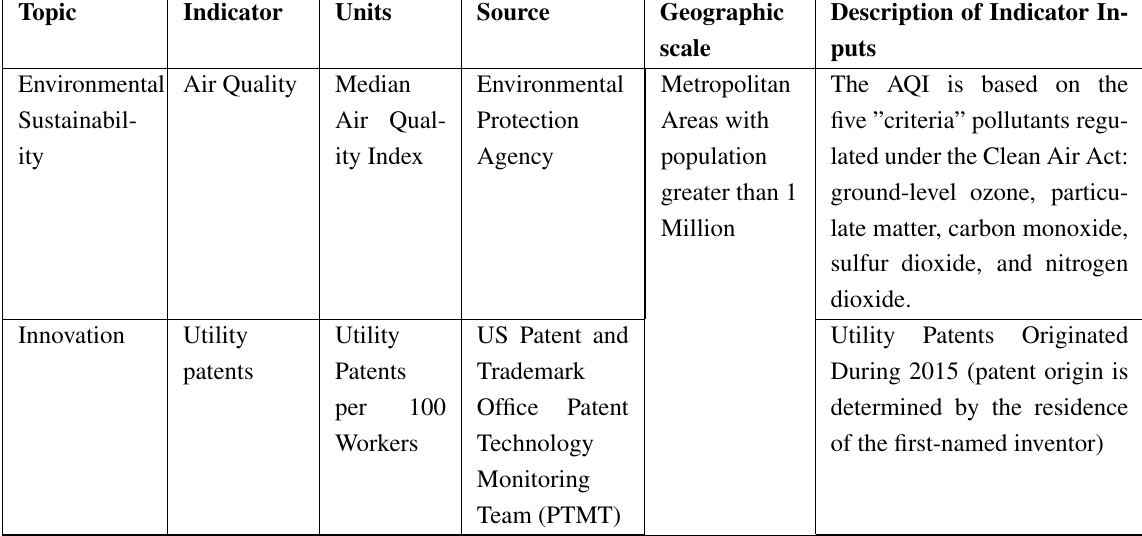
Table 2. Indicators chosen for the SustaIn-LED